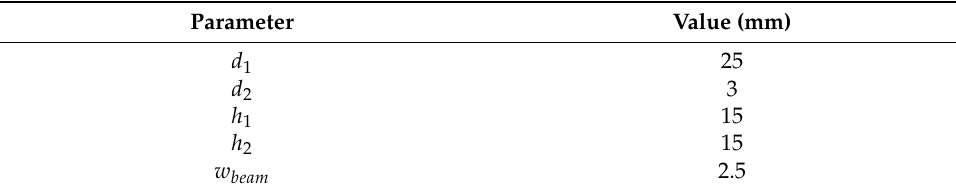
Table 1. Geometrical parameters of the interconnected metamaterial .